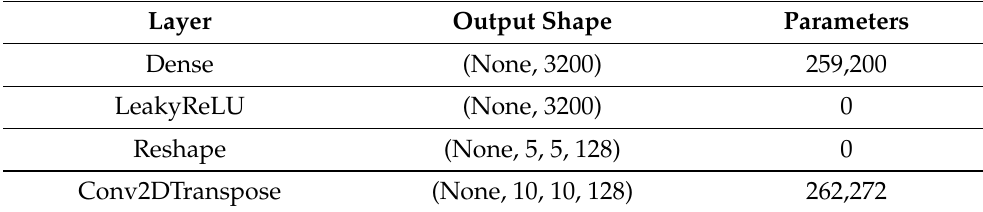
Table 6. Structure of GAN generator